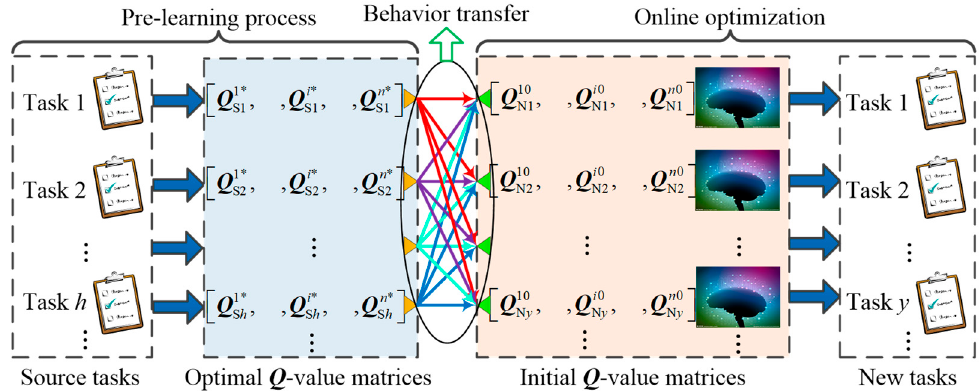
Figure 2. The principle of knowledge learning of the TBO inspired by the nectar gathering of bees.